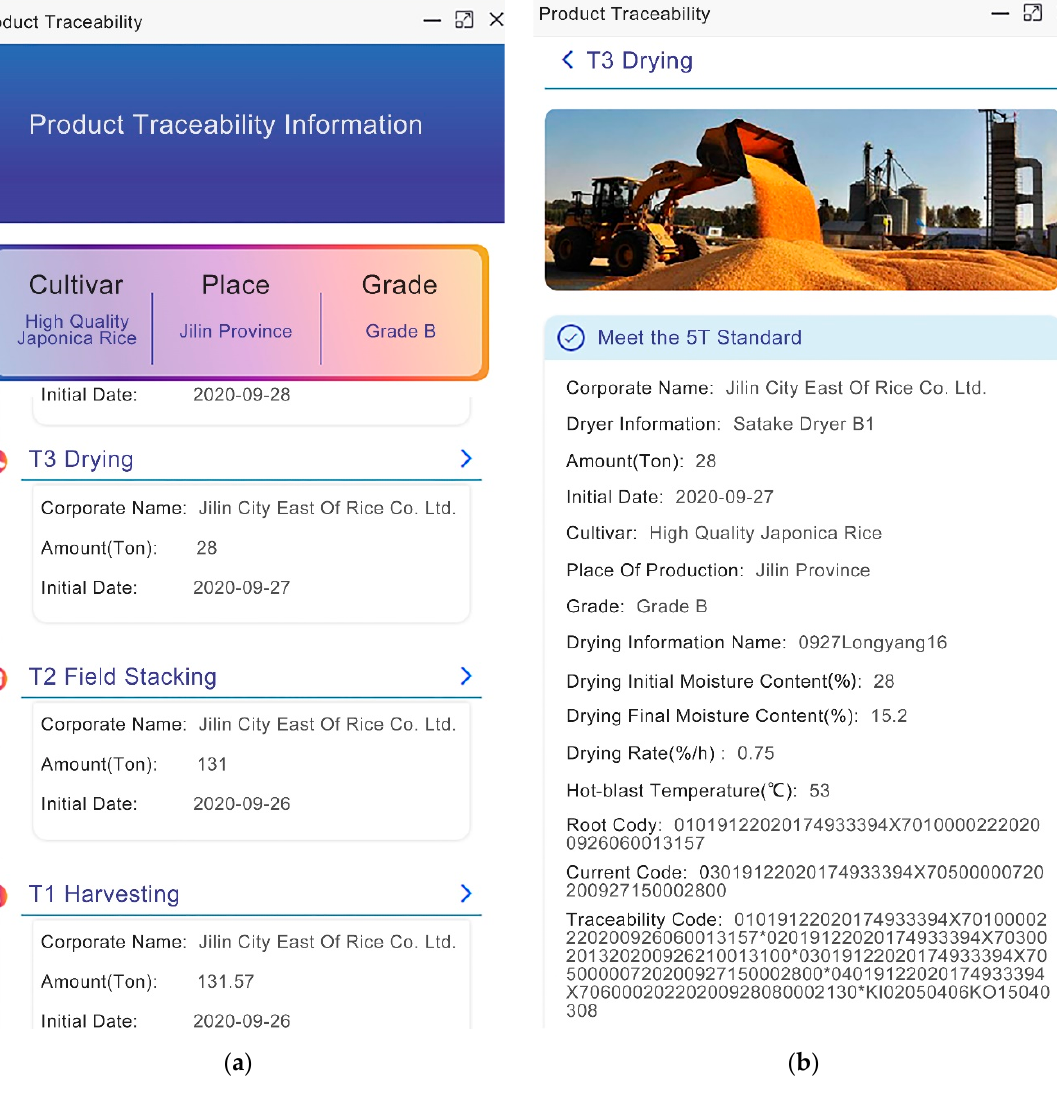
Figure 15. Product traceability interface of the mobile terminal. ( a ) data for the grain period events. ( b ) data and codes for the drying (T 3 ) event.